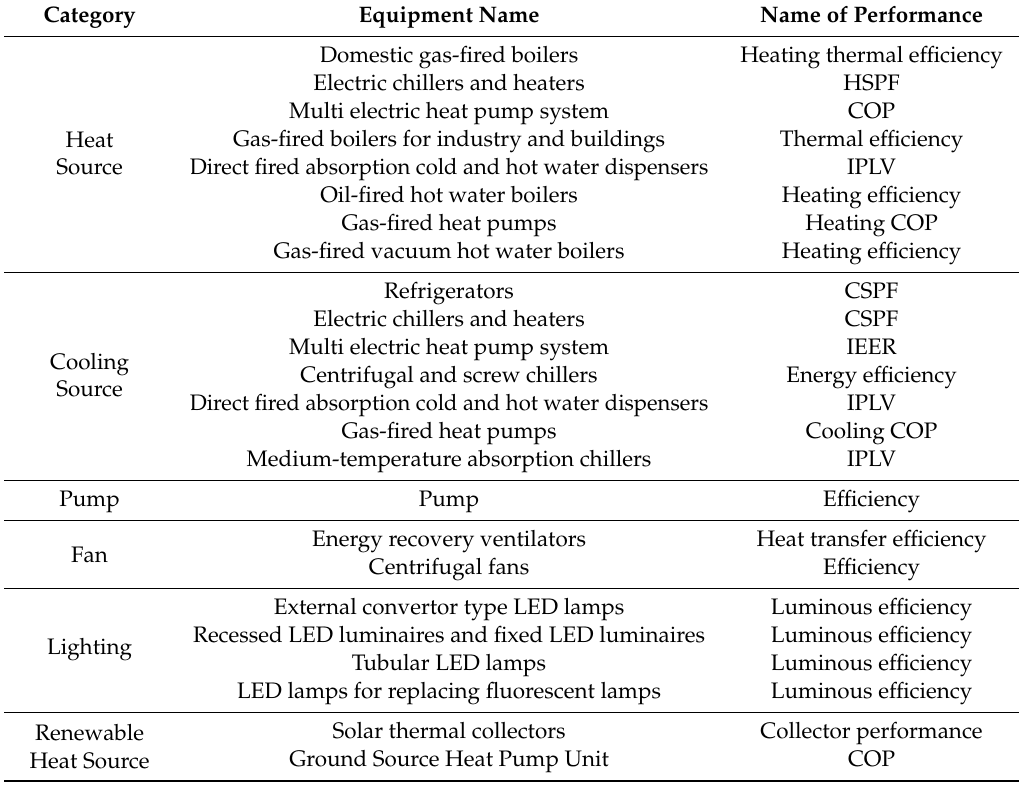
Table 6. Performance contents of the